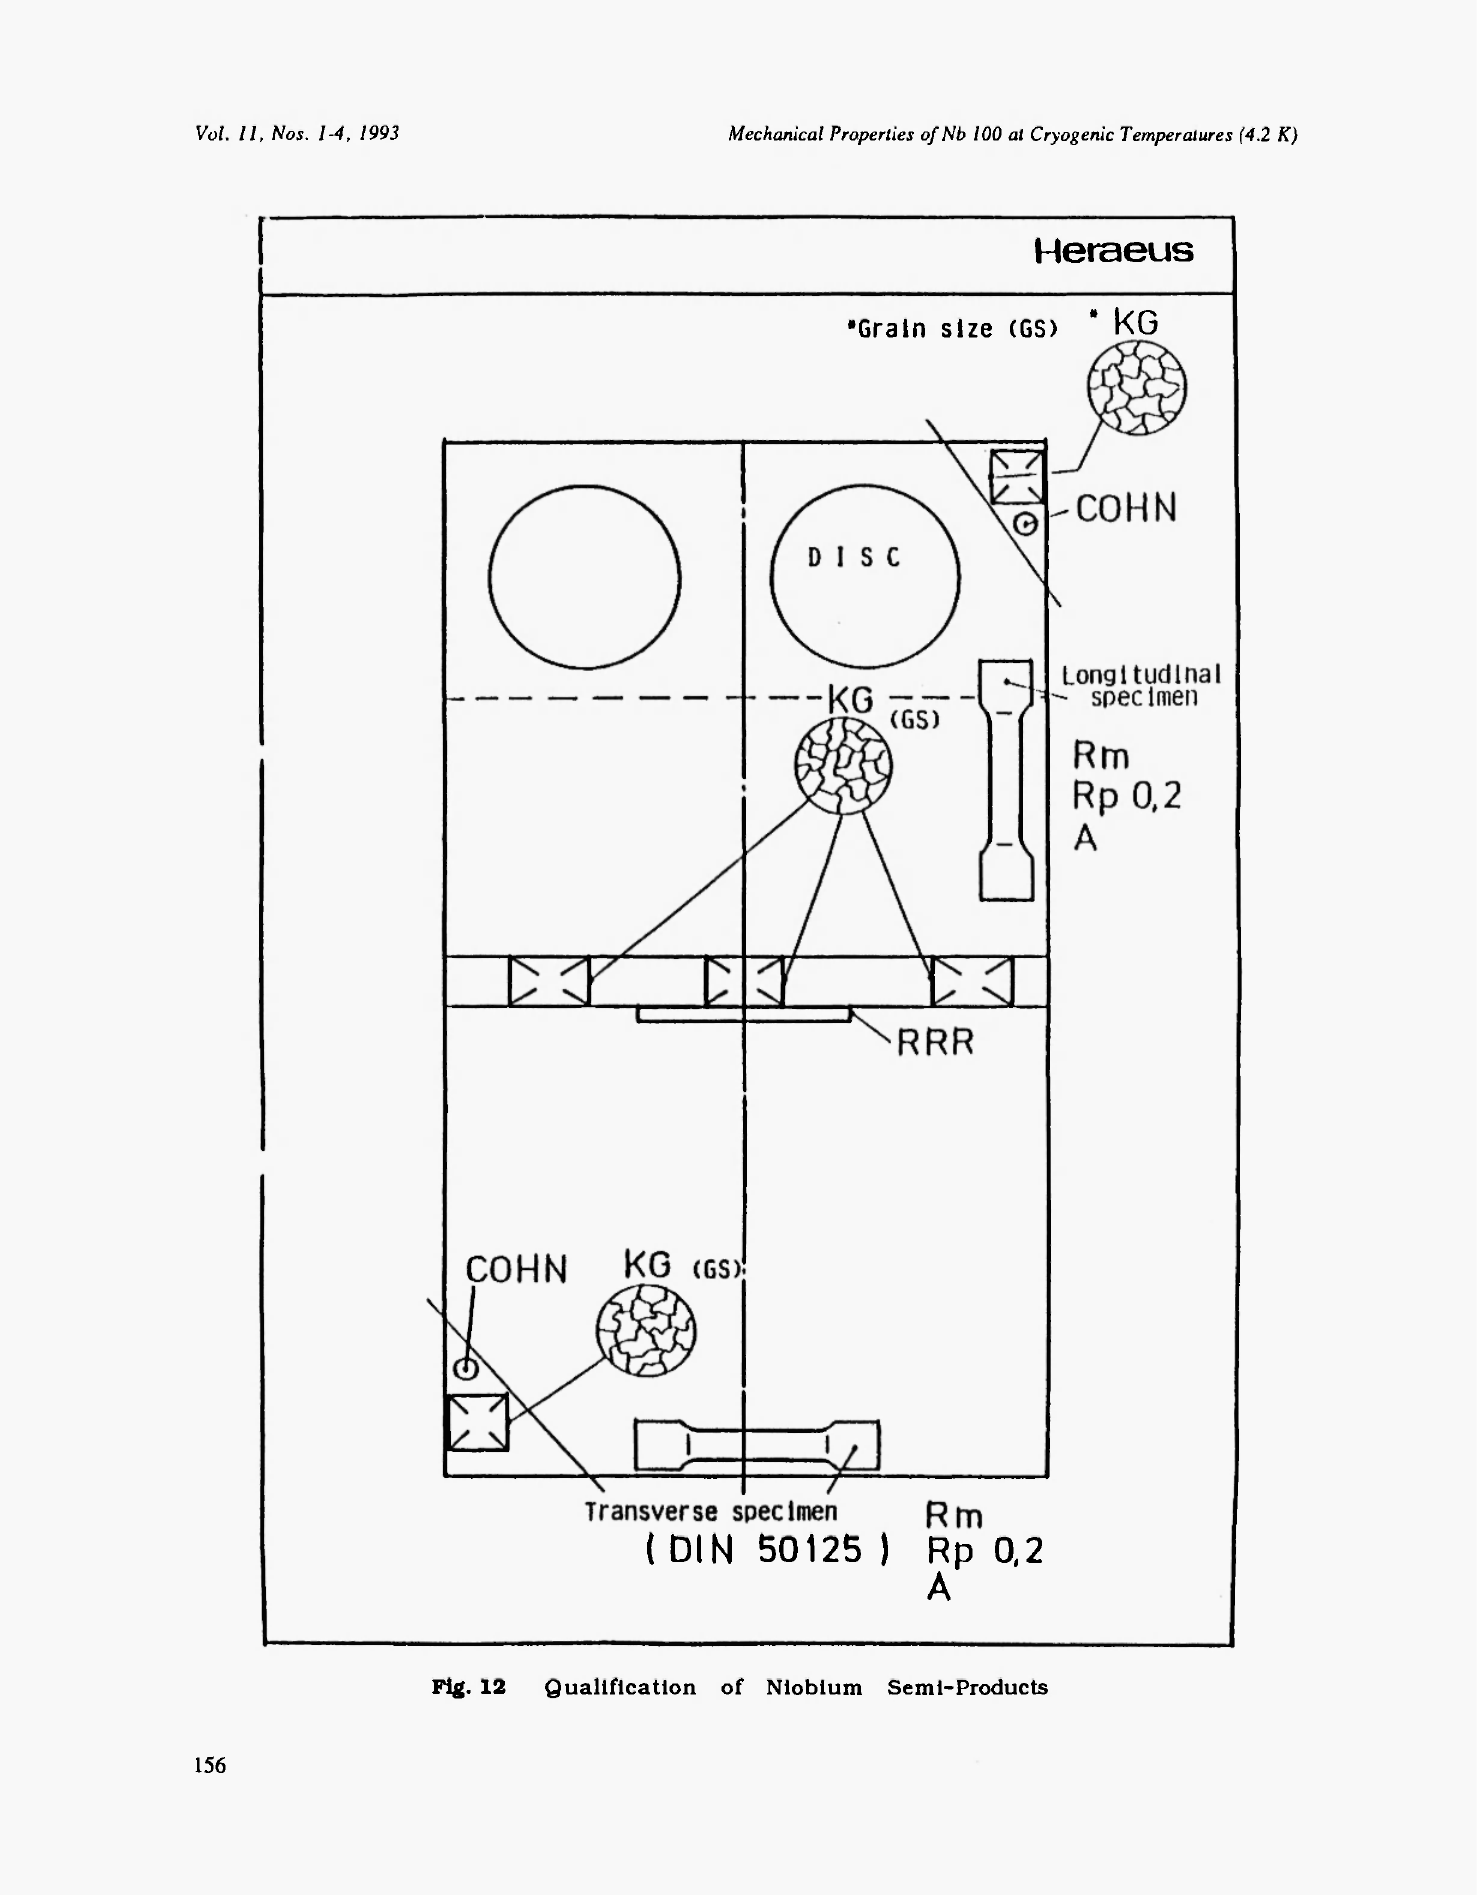
Qualification of Niobium